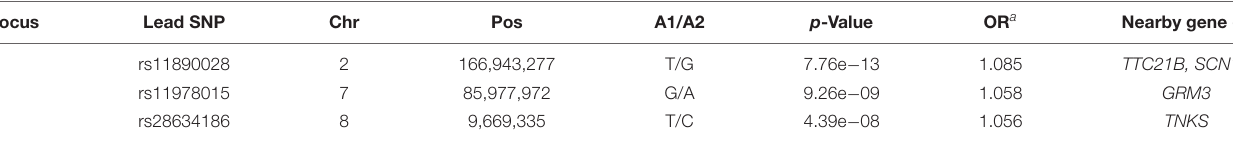
FIGURE 1 | Meta-analysis of four large-scale genome-wide association studies (GWASs) identified two novel risk loci for epilepsy. Manhattan plot of the meta-analysis of epilepsy (26,352 cases and 7,74,517 controls). The risk loci on 7q21.11 (lead SNP rs11978015, p = 9.26 × 10 - 9 ) and 8p23.1 (lead SNP rs28634186, p = 4.39 × 10 - 8 ) are newly identified in the present study. TABLE 1 | Genome-wide significant (GWS) loci identified in this study.